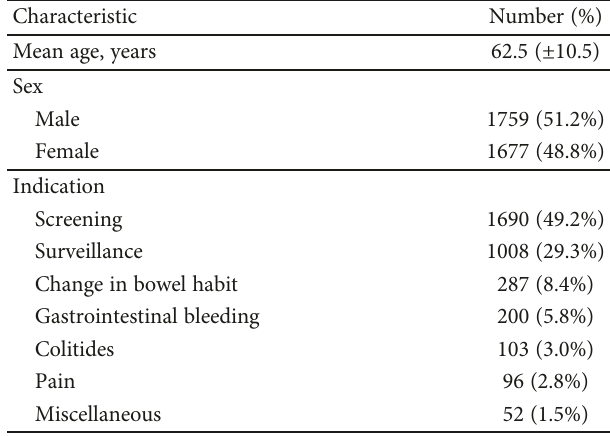
Table 1: Patient demographics and clinical indications for colonoscopy ( n = 3436